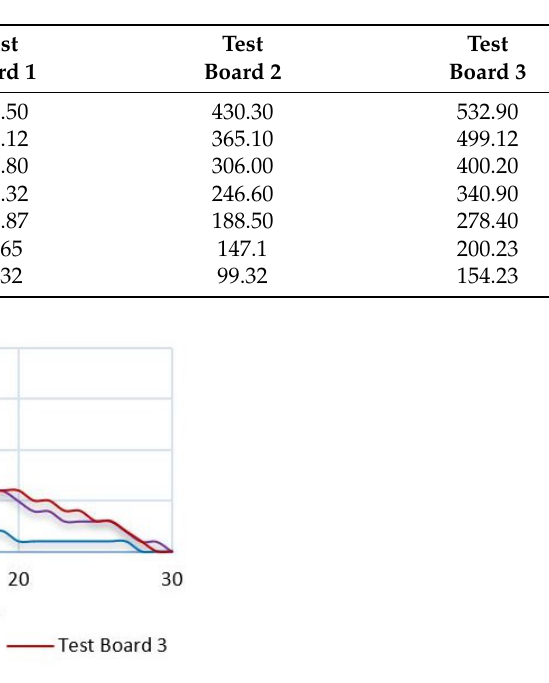
Figure 27. Number of tests performed and the number of penalties recorded. Table 5. Summary of the number of